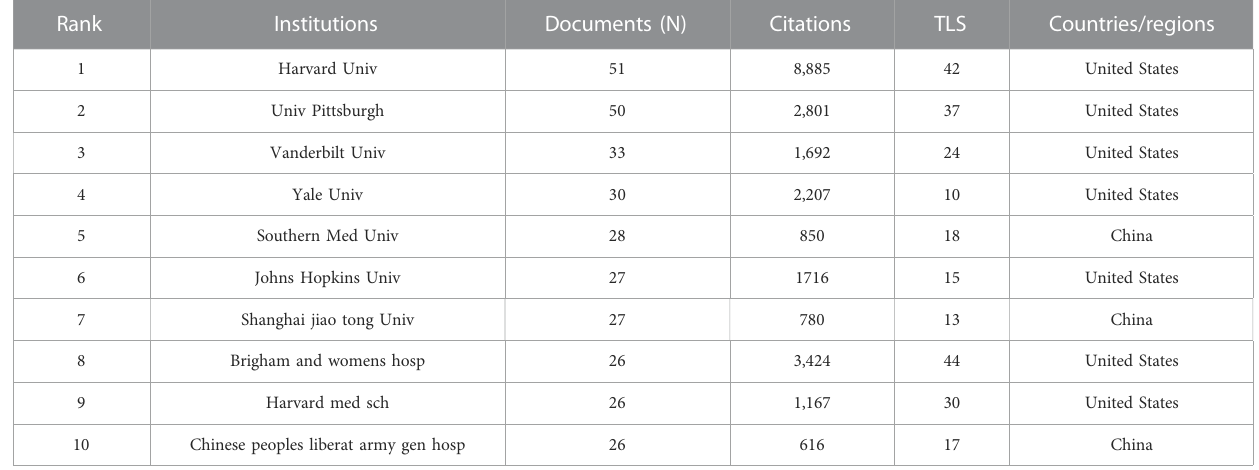
TABLE 2 Top 10 institutions ranked by the numbers of publications.